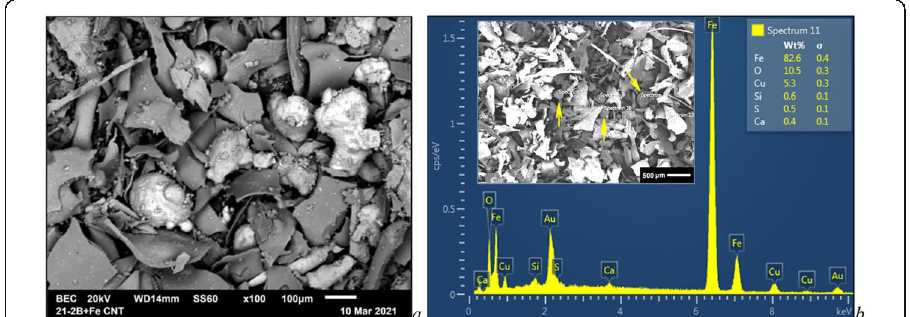
Fig. 10 Spherical metallic particles separated by HVG treatment of molten GPIS ( а ) and their EDS spectrogram ( b